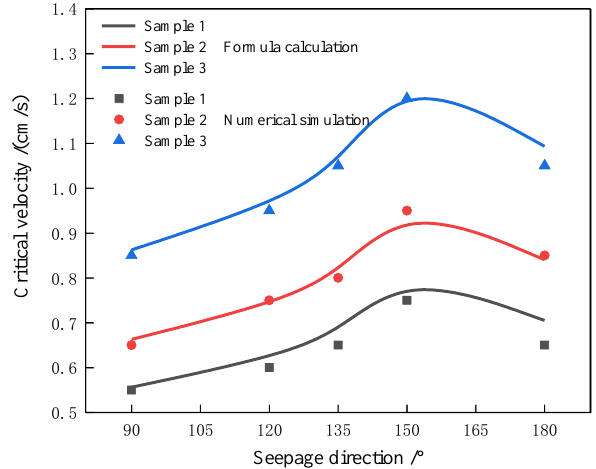
Figure 8. Critical velocity of particle initiation in different seepage